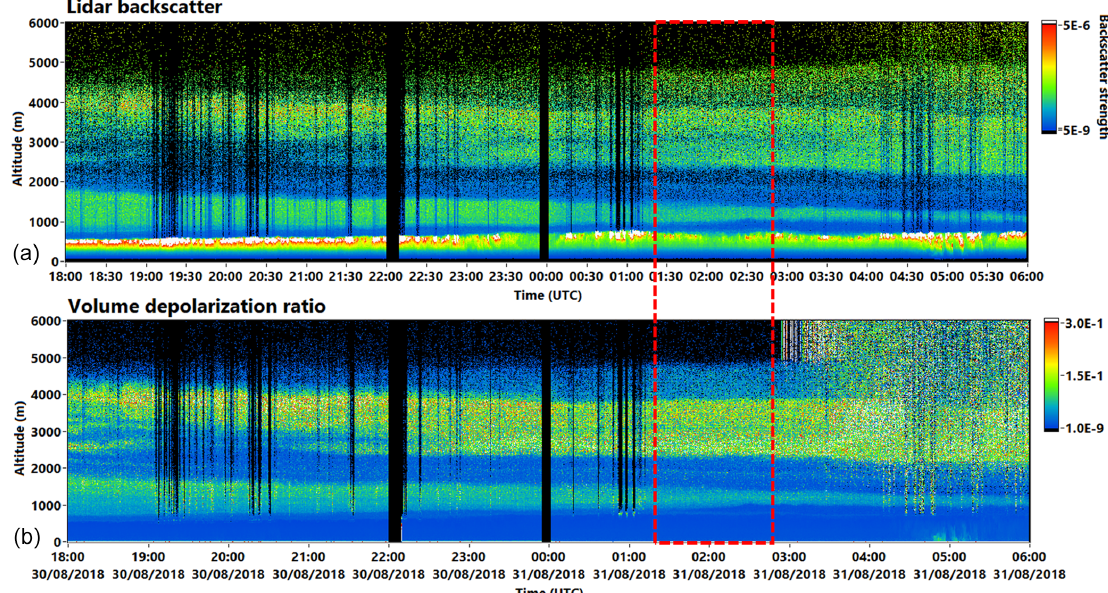
Figure 3. Color plot of the lidar backscatter signal at 1064nm (a) and volume depolarization ratio (b) at 532nm above Haifa on 30 Au- gust 2018 at 18:00UTC to 31 August 2018 at 06:00UTC. The time period used for the case study is marked by a red